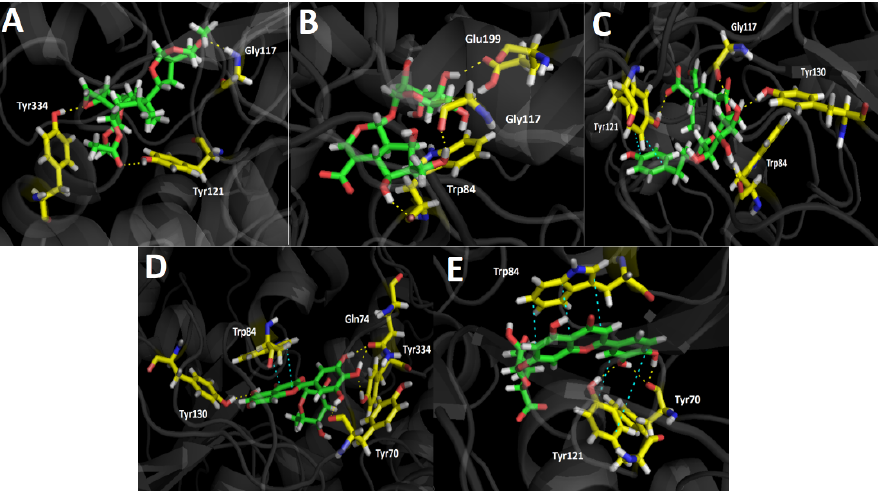
Figure 4. Predicted binding mode and predicted intermolecular interactions of the selected major compounds in Gaultheria pumila berries extract and the residues of the Torpedo Californica acetyl- cholinesterase ( Tc AChE) catalytic site. Yellow dotted lines indicate hydrogen bond interactions and cyan dotted lines represent π – π interactions. ( A ) Scupolin I in the catalytic site; ( B ) Unedide in the catalytic site; ( C ) Nuzhenal B in the catalytic site; ( D ) Myricetin O -rhamnoside in the catalytic site; and ( E ) Luteolin 7-glucuronide in the catalytic site.